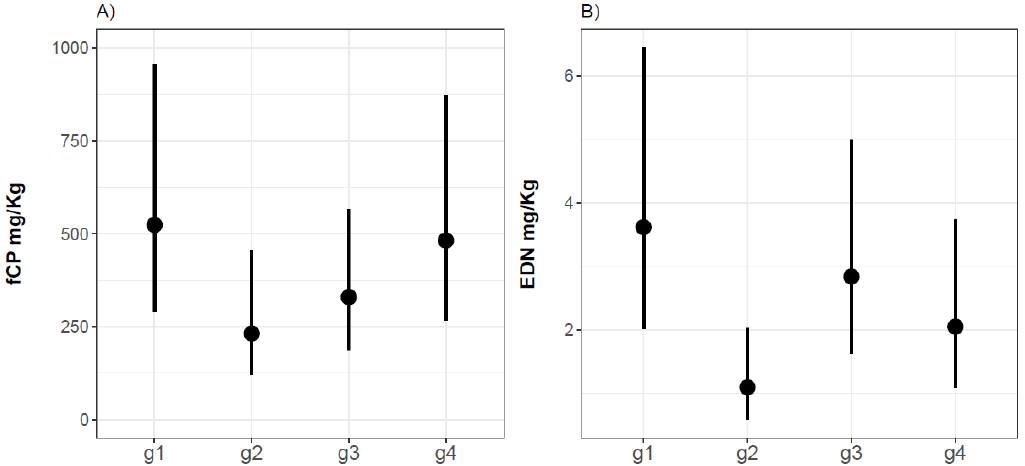
Figure 2. Plot with the distribution of fecal calprotectin (fCP) ( A ) and fecal eosinophil-derived neurotoxin (fEDN) ( B ) concentrations at recruitment for each group: non-IgE-mediated CMPA infants (G1), infants with mild GI functional disorders (G2), healthy infants (G3), and children with infections (G4).